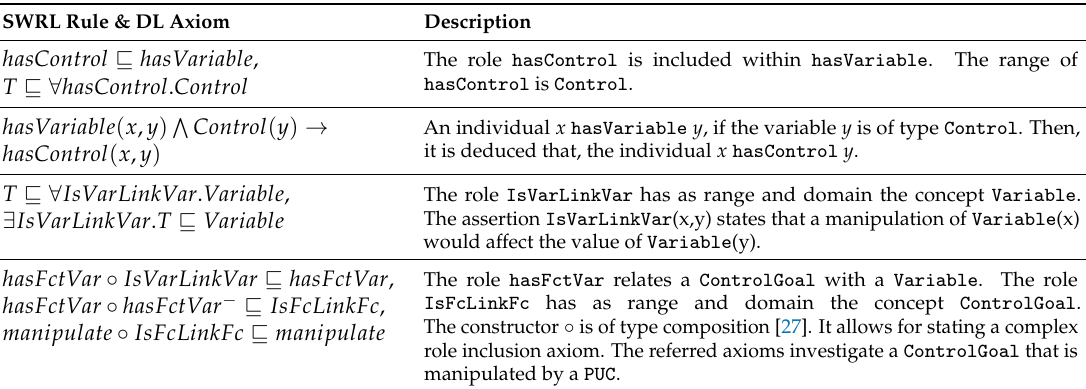
Table 4. Axioms within the EMS- TBox and SWRL